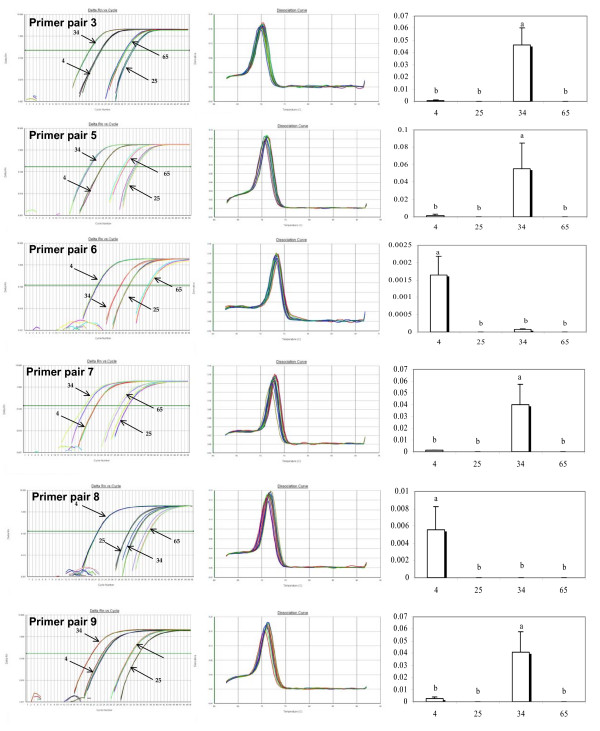
Outcomes of level of cDNA expression across families for primers (3, 5, 6, 7, 8, 9) technically validated through the analysis of the melting curve of the EST [AJ565694]. From left to right: Plot of PCR cycle number against logarithm PCR product amount; Derivative Melting Curve; Statistical results of level of cDNA expression across families based on a multiple comparison test (Tukey). Family numbers are reported on the horizontal axis, histograms sharing a letter are not significantly different (P < 0.05).